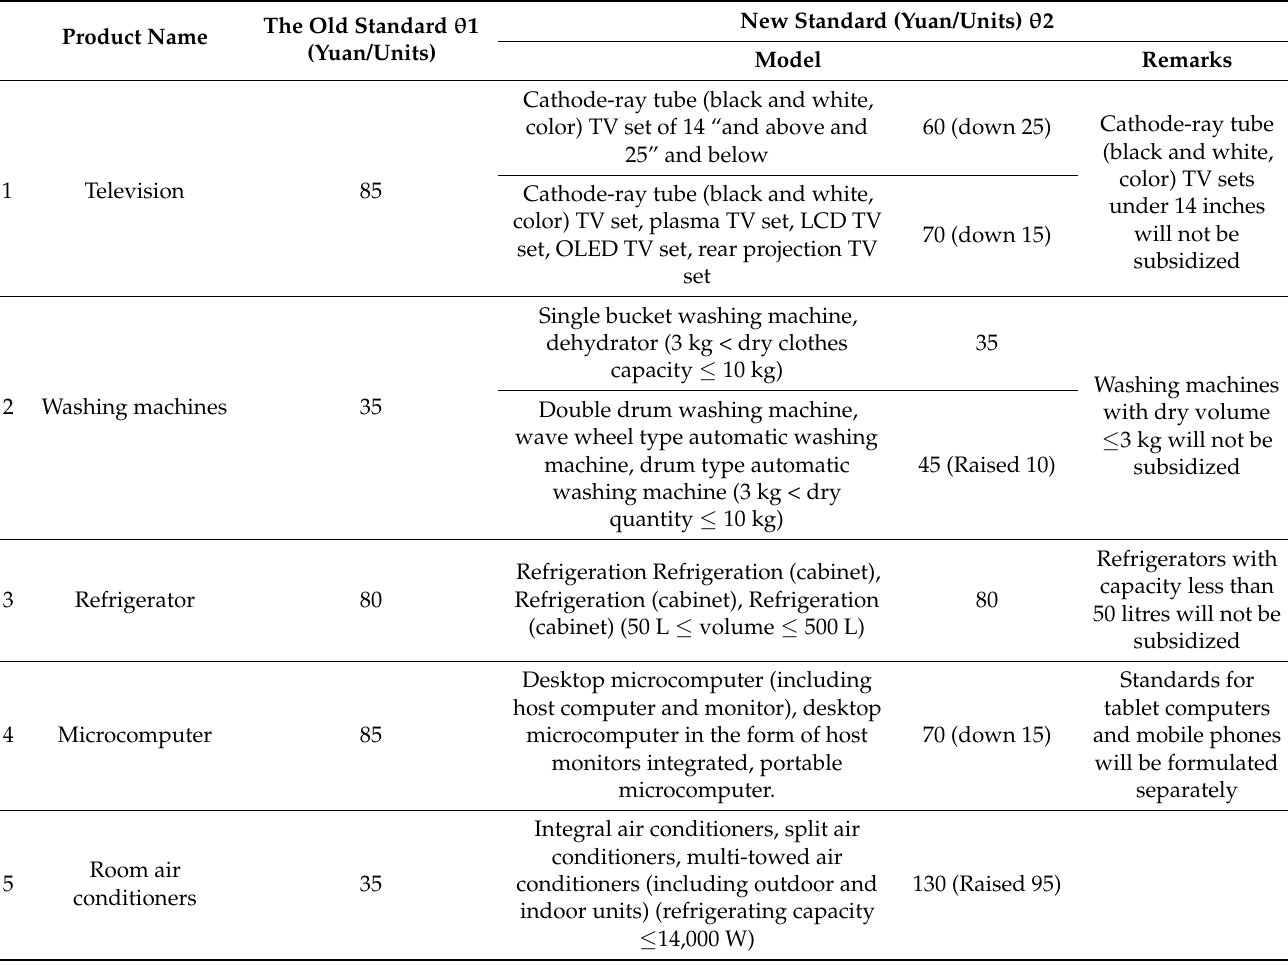
Table 2. Comparison between the old and new WEEE fund subsidy standards in